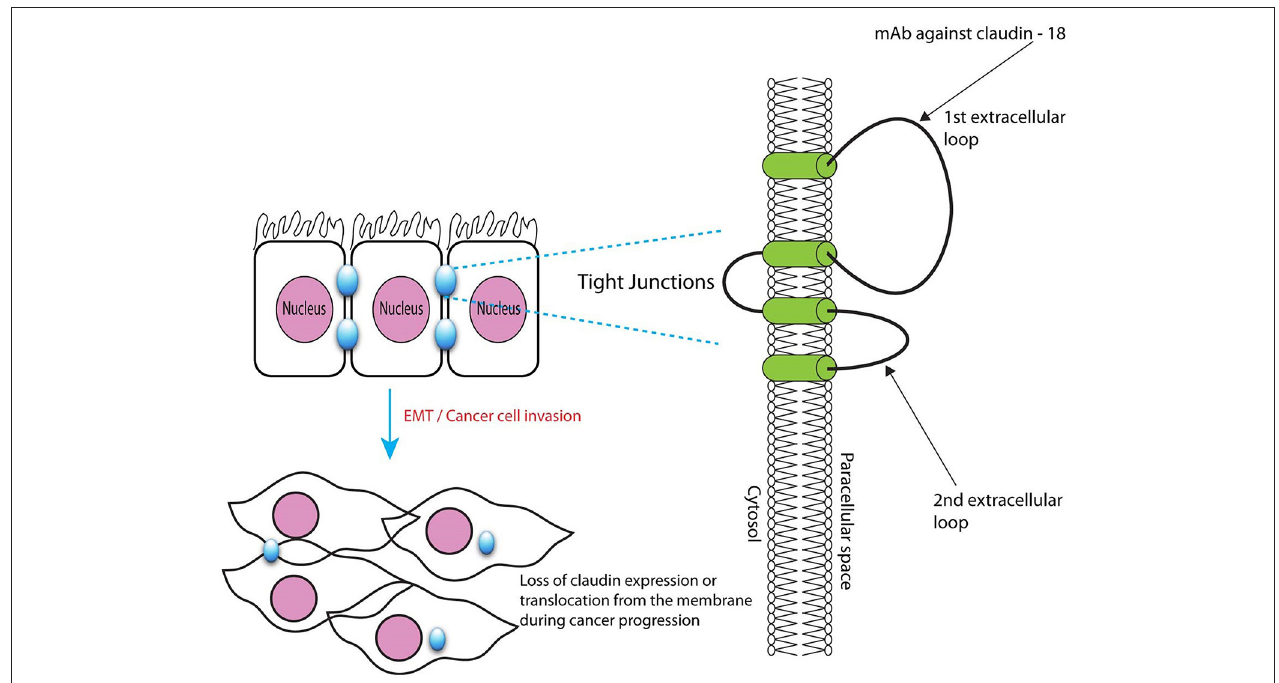
FIGURE 3 | Microscopic structure of tight junctions showing claudin 18.2 with binding site for monoclonal antibody